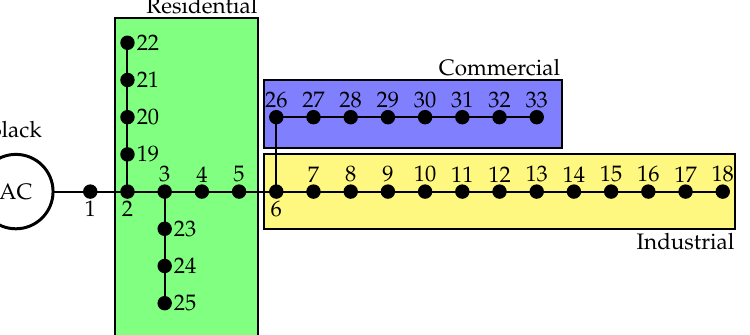
Figure 3. Grid configuration for the IEEE 33-bus system, with different shaded areas representing different types of load. Table 1. Electrical parameters of the 33-node test feeder.